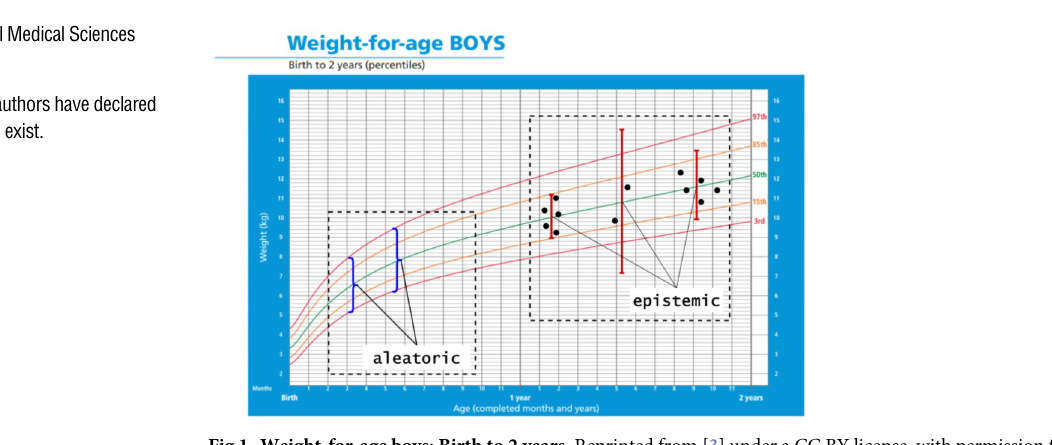
Fig 1. Weight-for-age boys: Birth to 2 years. Reprinted from [3] under a CC BY license, with permission from World Health Organization, original copyright (2021). The percentiles show the distribution of weights in boys form birth to 2 years. Black dots: observations; red error bars: epistemic uncertainty; blue curly brackets: aleatoric uncertainty.